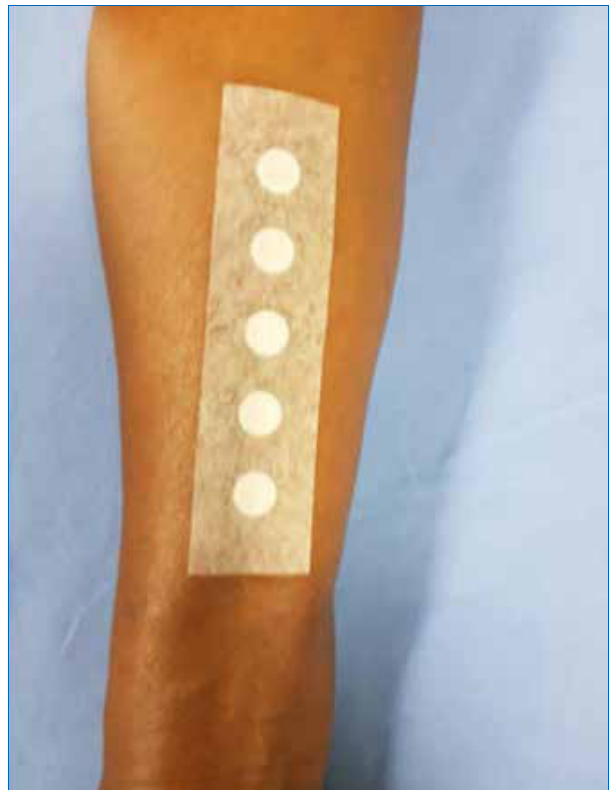
Figure 4: Patch test on the